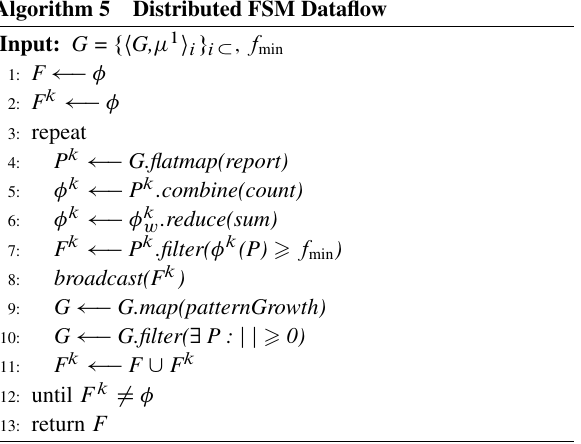
Algorithm 5 Distributed FSM